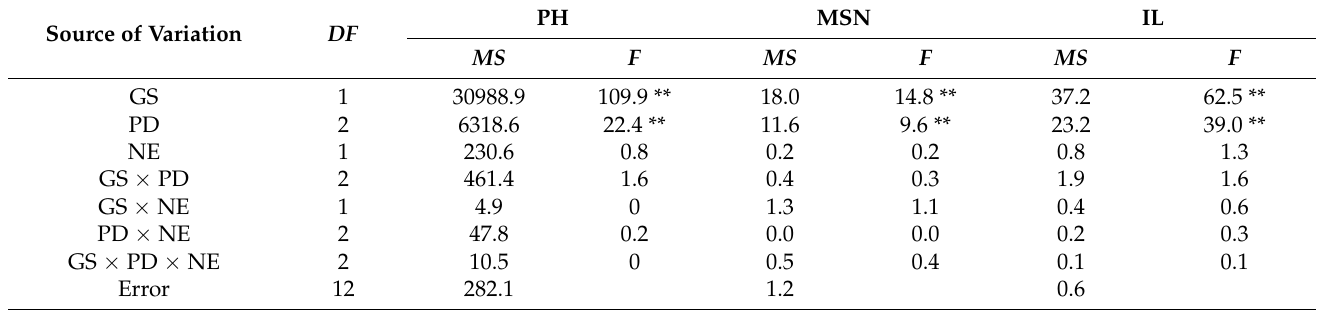
Table 2. Analysis of variance of three factors of agronomic traits in spring sowing net house.